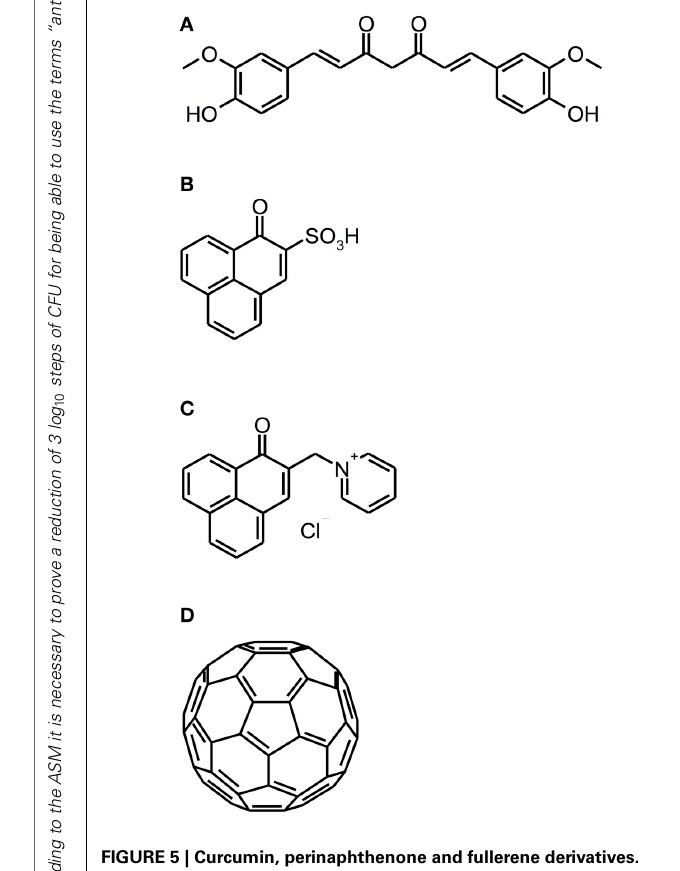
FIGURE 5 | Curcumin, perinaphthenone and fullerene derivatives. Chemical structures of curcumin, perinaphthenone and fullerene derivatives: (A) Curcumin. (B) PNS. (C) SAPYR. (D) Fullerene